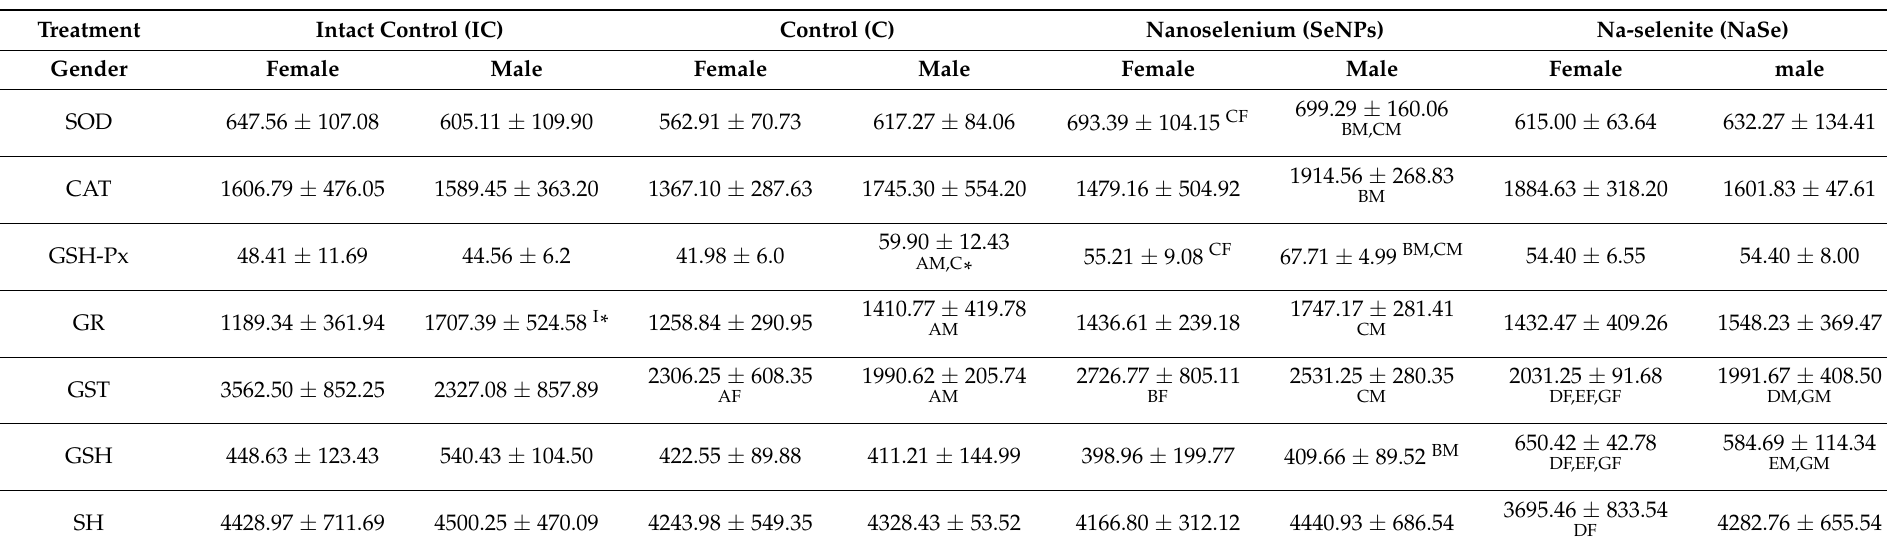
Table 3. The activities of SOD (U/g wet mass), CAT ( µ mol H 2 O 2 /min/g wet mass), GSH-Px ( µ mol NADPH/min/g wet mass), GR (nmol NADPH/min/g wet mass) and GST (nmol GSH/min/g wet mass), as well as total GSH ( µ mol/ g tissue) and SH groups (nmol/g tissue) concentrations in placenta. The effects between fetuses gender, as well as between placenta of pregnant Wistar albino